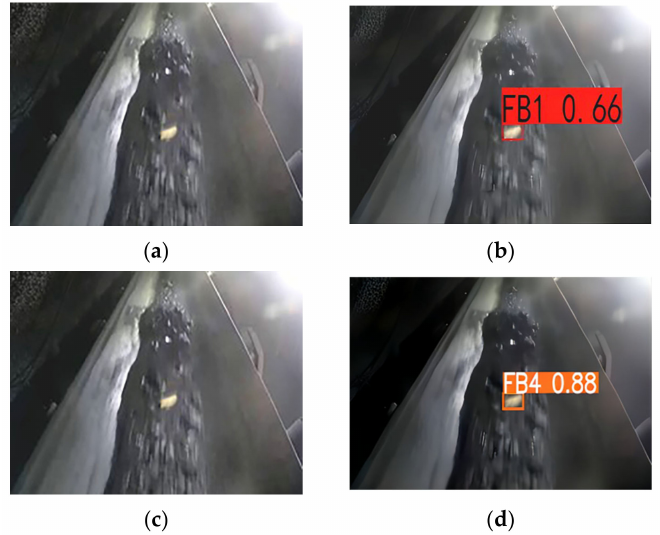
Figure 13. Recognition results of various algorithms. ( a ) Recognition results of SSD. ( b ) Recognition results of YOLOv3. ( c ) Recognition results of YOLOv5. ( d ) Recognition results of the improved YOLOv5